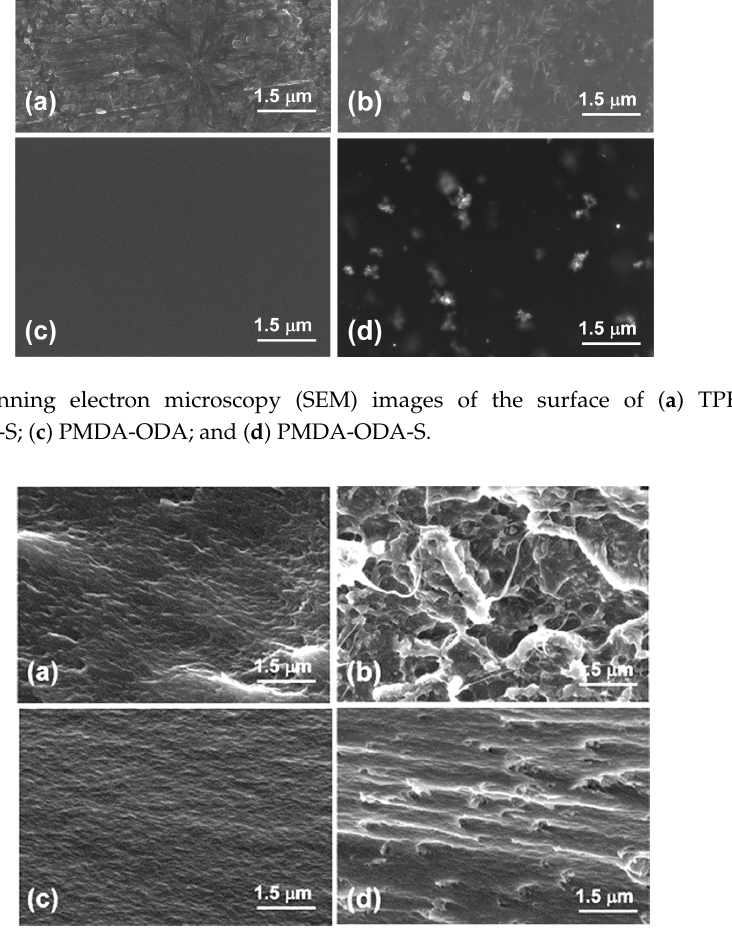
Figure 3. Scanning electron microscopy (SEM) images of the surface of ( a ) TPEQ-ODPA; ( b ) TPEQ- ODPA-S; ( c ) PMDA-ODA; and ( d ) PMDA-ODA-S.